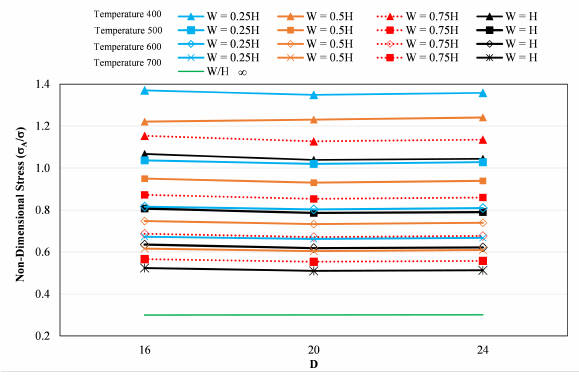
Figure 13: Relationship between σ A / σ with the pipe diameter (inch).